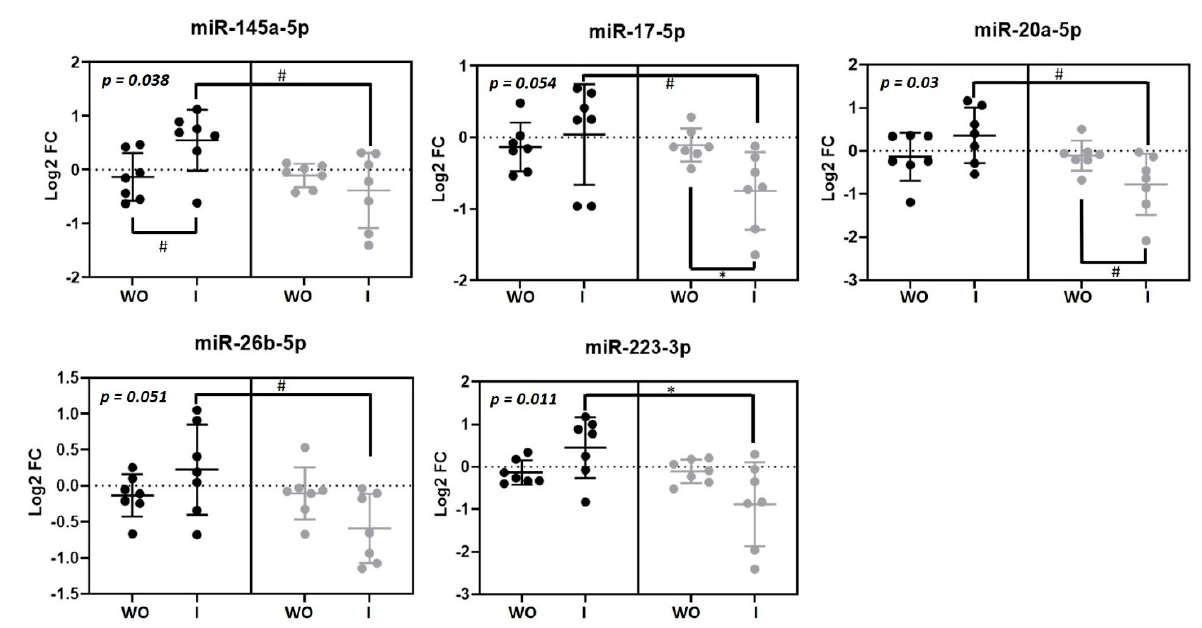
Figure 3. Macrophage microRNAs modulated by beer and non-alcoholic beer. Scatterplots showing Log 2 transformed relative fold change (FC) microRNAs in each intervention phase ( n = 7). Black dots ( ● ) correspond to beer intervention and grey dots ( ● ) correspond to non-alcoholic beer intervention. Macrophage microRNA levels were calculated with the 2 −ΔΔ Ct method comparing with each basal timepoint. Mean ± SD of each timepoint is shown. p -value was calculated with repeated measurements ANOVA. WO: washout; I: intervention. * p < 0.05; # p < 0.1.